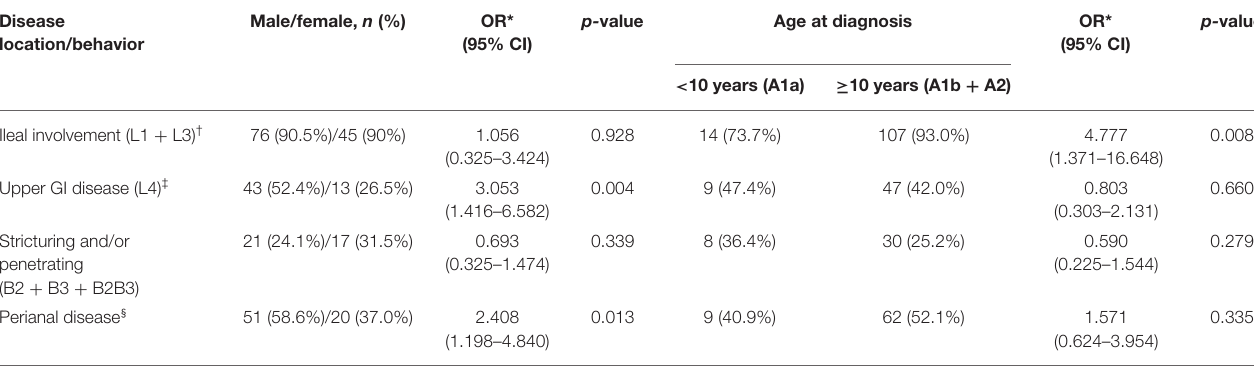
TABLE 2 | Association between demographic characteristics of patients and disease features according to the Paris classification (13). Disease